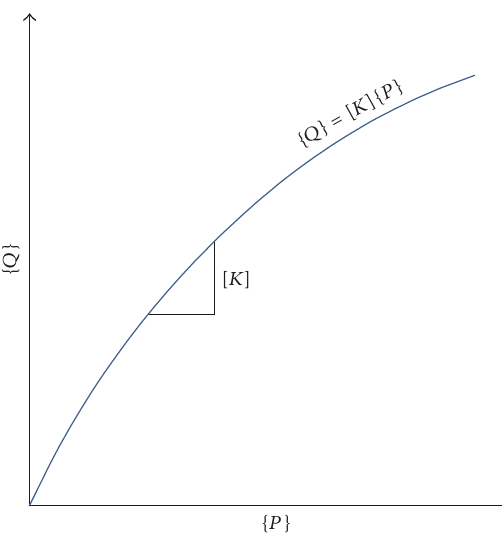
Figure 4: Relationship between the flow rate and pore